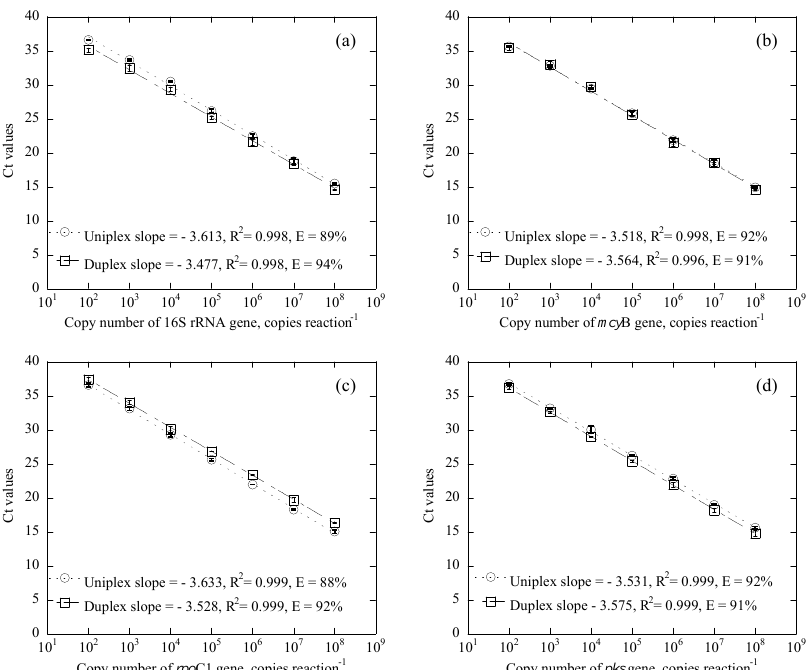
Figure 1. Duplex and uniplex qPCR standard curves for Microcystis and Cylindrospermopsis systems, where ( a ) and ( b ) are for the duplex system of the 16S rRNA gene and mcyB gene, ( c ) and ( d ) are for the duplex system of the rpoC1 gene and pks gene, represents the results from the uniplex system, (cid:35) represents the results from the duplex system, and Error bars represent the standard deviation of 2 replicates.